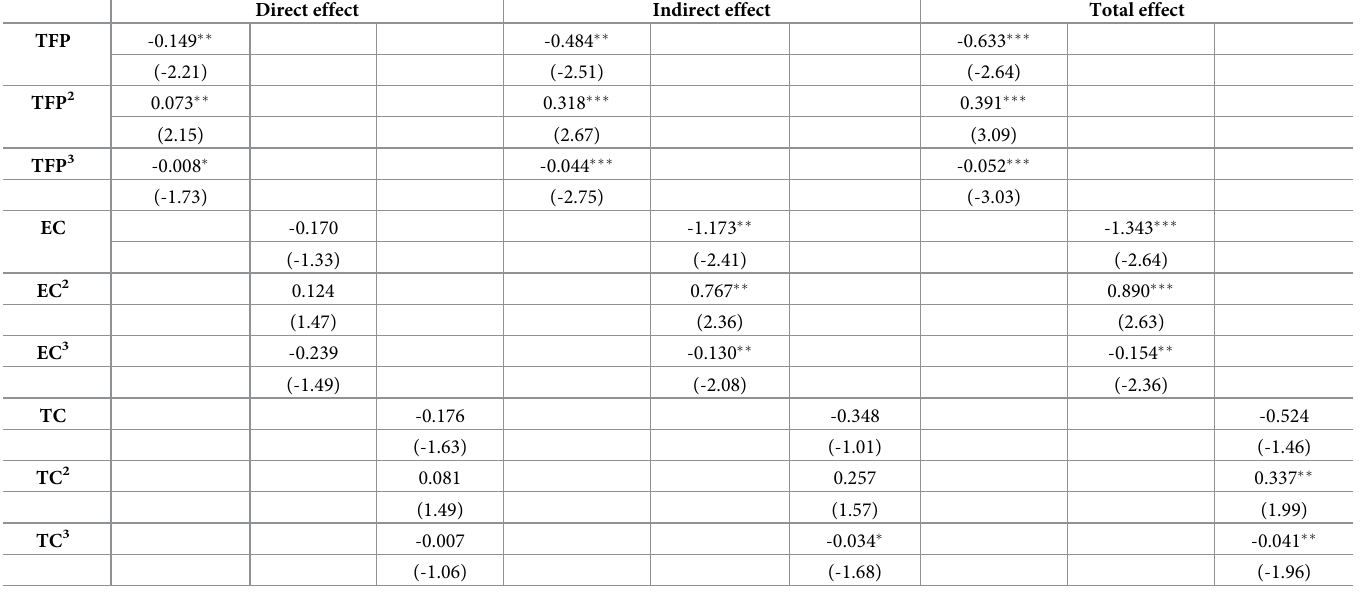
Table 12. Direct effect, indirect effect and total